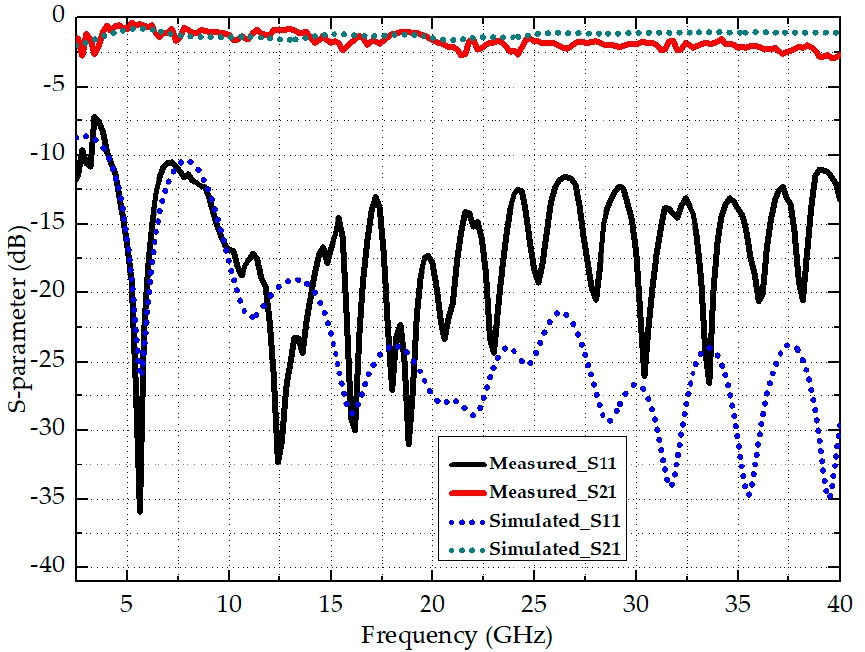
Figure 12. Results of the measured and simulated S-parameters. Table 4. Performance comparison of the proposed microstrip-to-slotline transition with the reported designs.